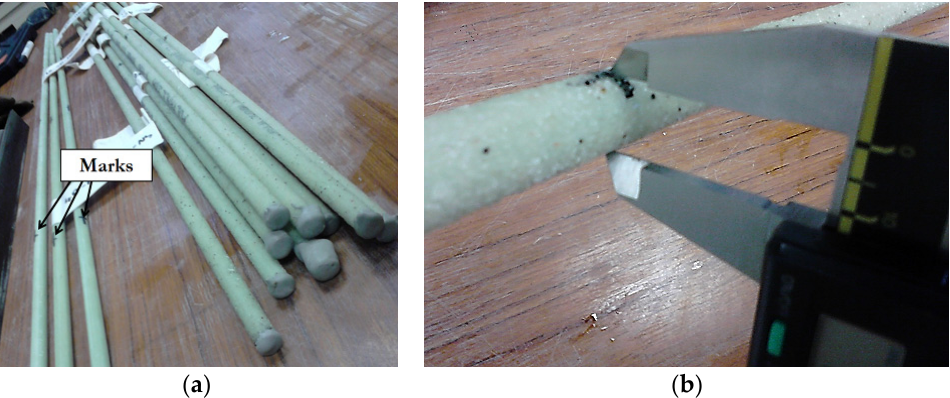
Figure 5. ( a ) Marked GFRP rebars used for monitoring the changes in mass/diameter over aging and ( b ) illustration of the diameter measurement on a sand-coated rebar (as a reminder, the nominal diameter of all rebars was 12.7 mm).